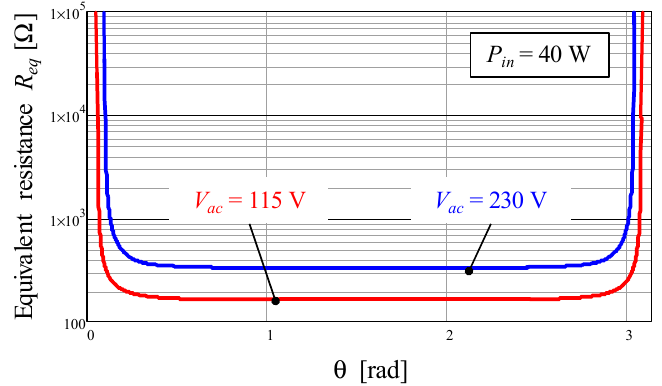
Figure 14. Variation of R eq ( θ ) along the sinusoid for the prototype converter caused by the ringing current.